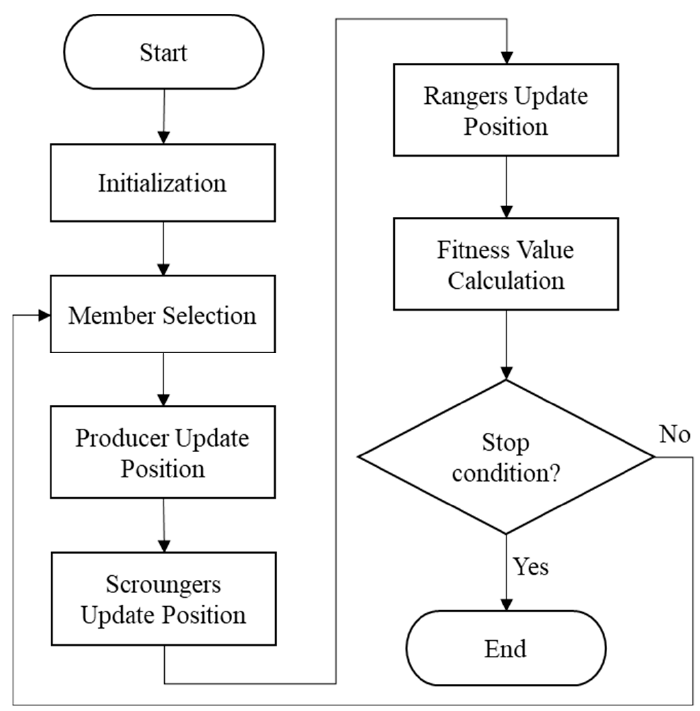
Figure 2. Flowchart of GSO algorithm.